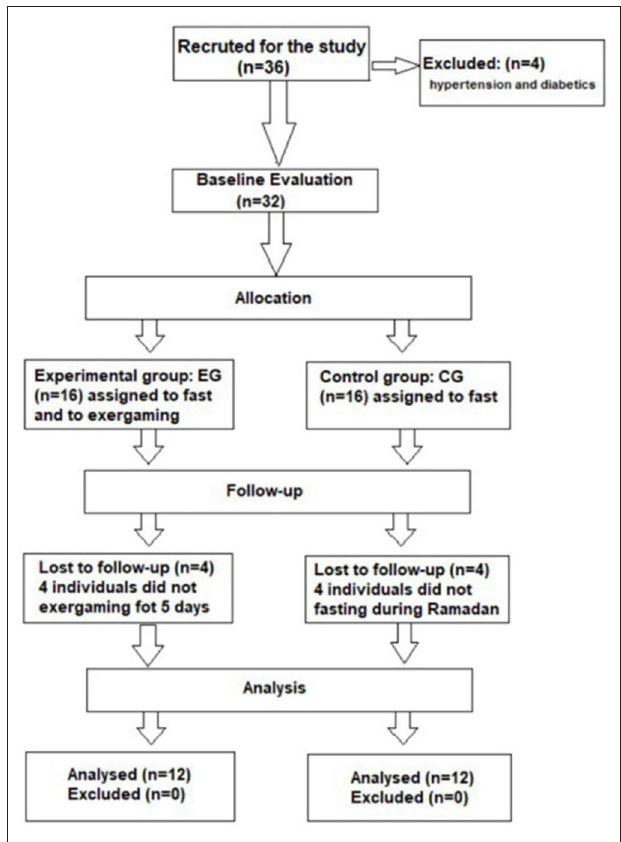
FIGURE 1 | Flow chart of participant’s